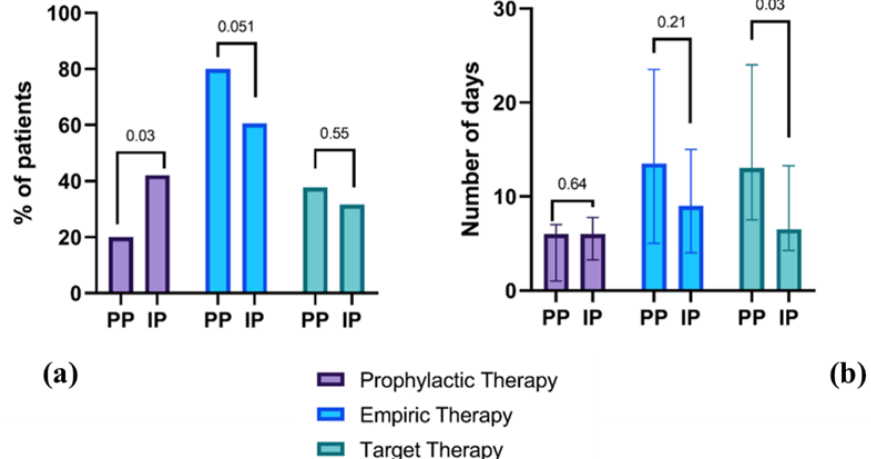
Figure 2. Comparison of different antimicrobial approaches before and during the pandemic. ( a ) Percentage of patients who underwent prophylactic, empiric and target therapy in the two study populations; ( b ) Number of days undergoing prophylactic, empiric and target therapy in the two years of analysis, i.e., pre-pandemic (2019) and intra-pandemic (2020). PP, pre-pandemic; IP, intra-pandemic.